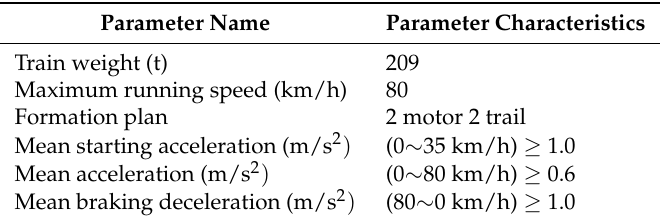
Table 2. The main parameters of the scenario about Jinpu line No.1 in Dalian.